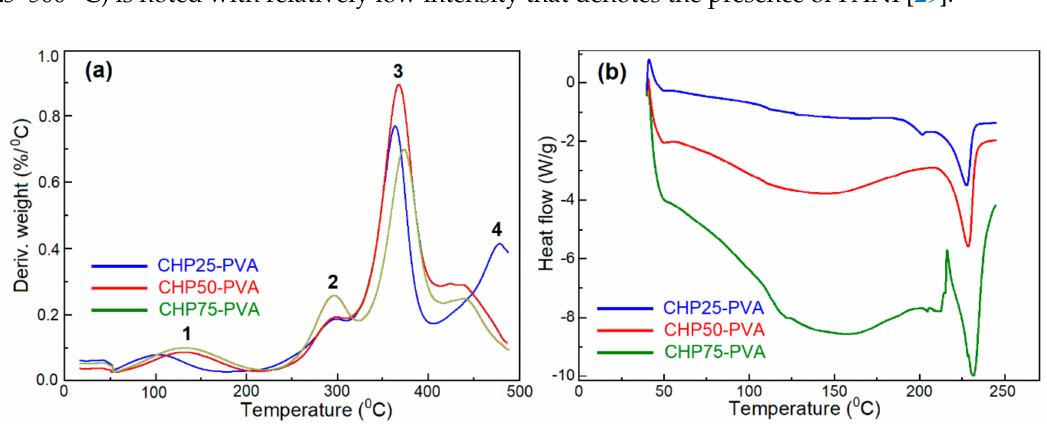
Figure 4. Thermal properties of polymer-based (PANI–CHT–PVA) composite films: ( a ) Di ff erential thermogravimetry (DTA) profiles; and ( b ) DSC profiles ( ↓ endo